Question: Which visualization type does this figure use?
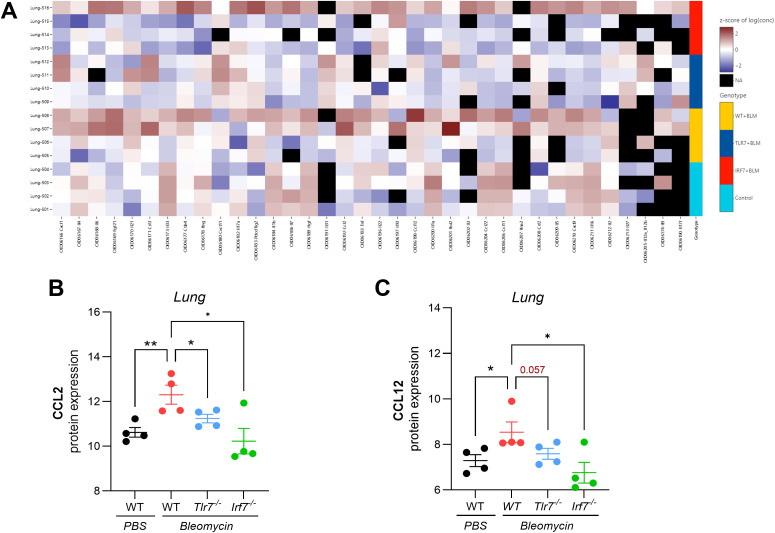
Answer: heatmap